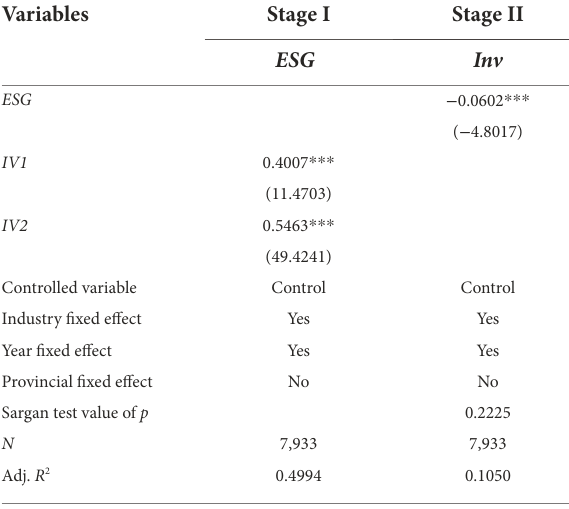
TABLE 11 Results of two-stage least squares regression.